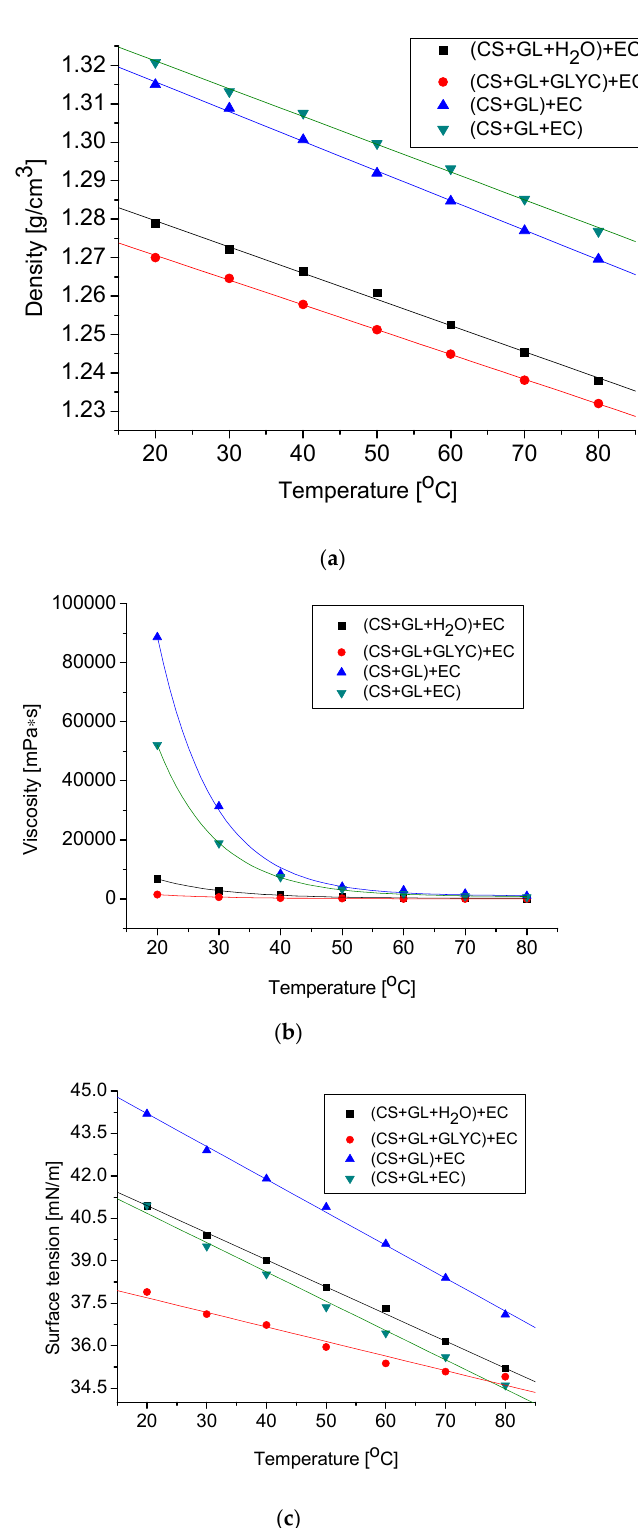
Figure 5. Changes of density ( a ), viscosity ( b ), and surface tension ( c ) of polyol as a function of temperature.